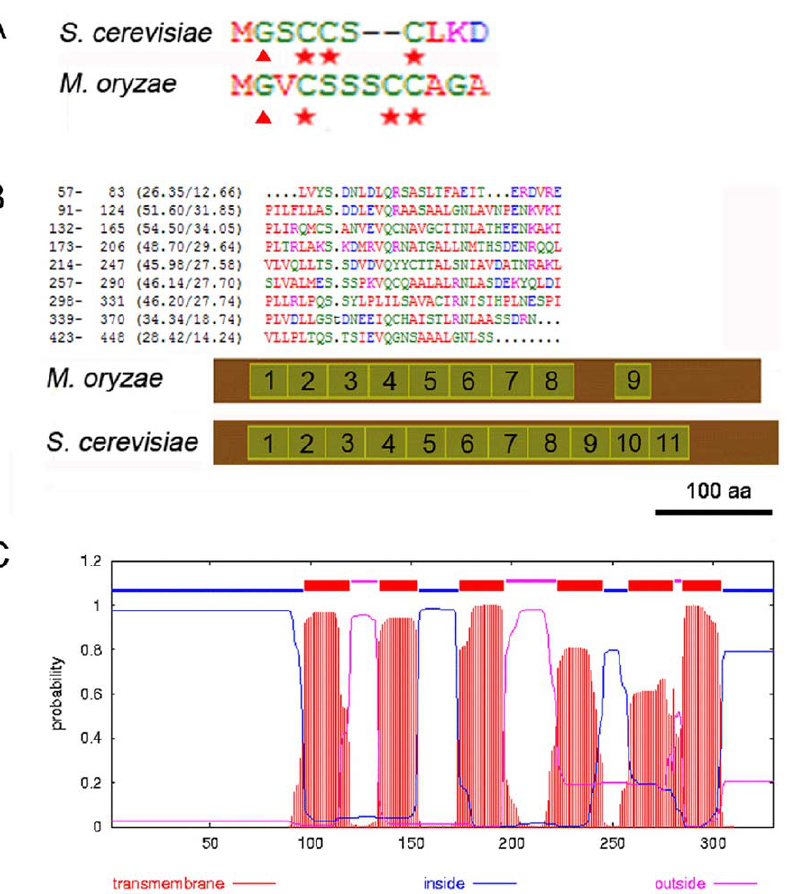
Figure 2. Bioinformatic identification of components of the S. cerevisiae PMN pathway in M. oryzae . ( A ) Alignment of acylation modification amino acids in the N-terminus of Vac8p from M. oryzae and S. cerevisiae . Triangles indicate putative myristoylation modification site (Gly) and stars indicate palmitoylation modification sites (Cys) that have been shown to be important for localisation and function of Vac8p in S. cerevisiae . Similar acylation modification sites are present in MoVac8p. ( B ) ARM repeat organization in MoVac8p is distinct from that of S. cerevisiae Vac8p. Upper panel: alignment of 9 ARM repeats from M. oryzae Vac8p. A dot indicates a space. Lower panel: Comparison of distribution of the ARM repeats in Vac8p between M. oryzae and S. cerevisiae . Scale bar indicate 100 amino acids. ( C ) MoTsc13p shares the same topology of six tramsmembrane domains as S. cerevisiae Tsc13p.